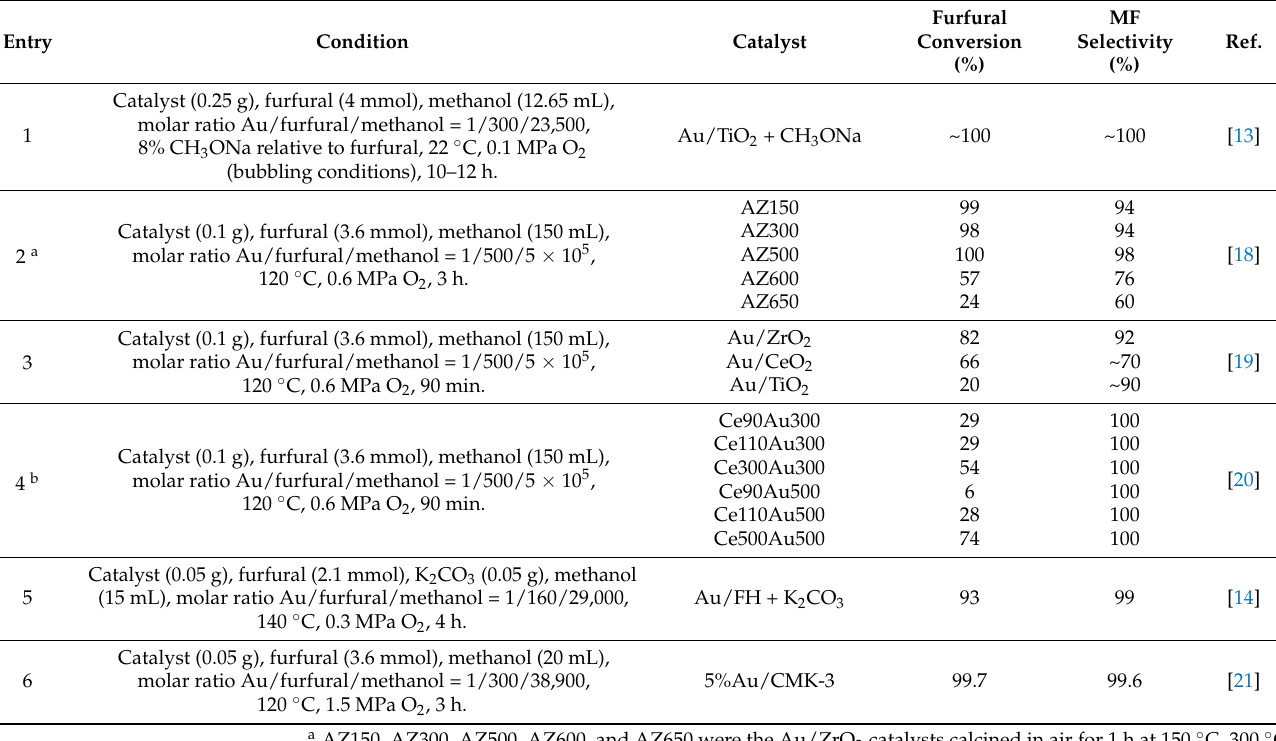
Table 1. Studies on the oxidative esterification of furfural to MF over noble metal catalysts.